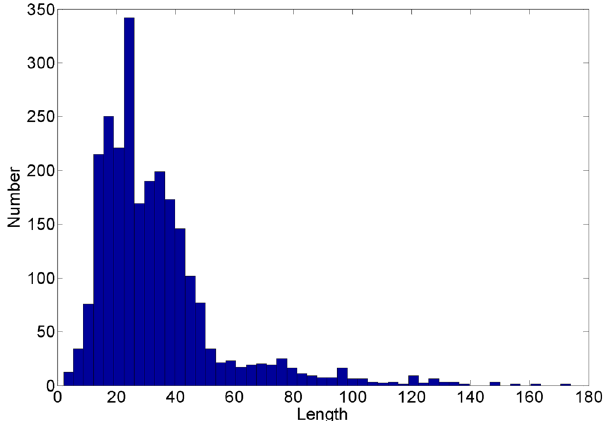
Figure 1. Sequence length distribution in APD.